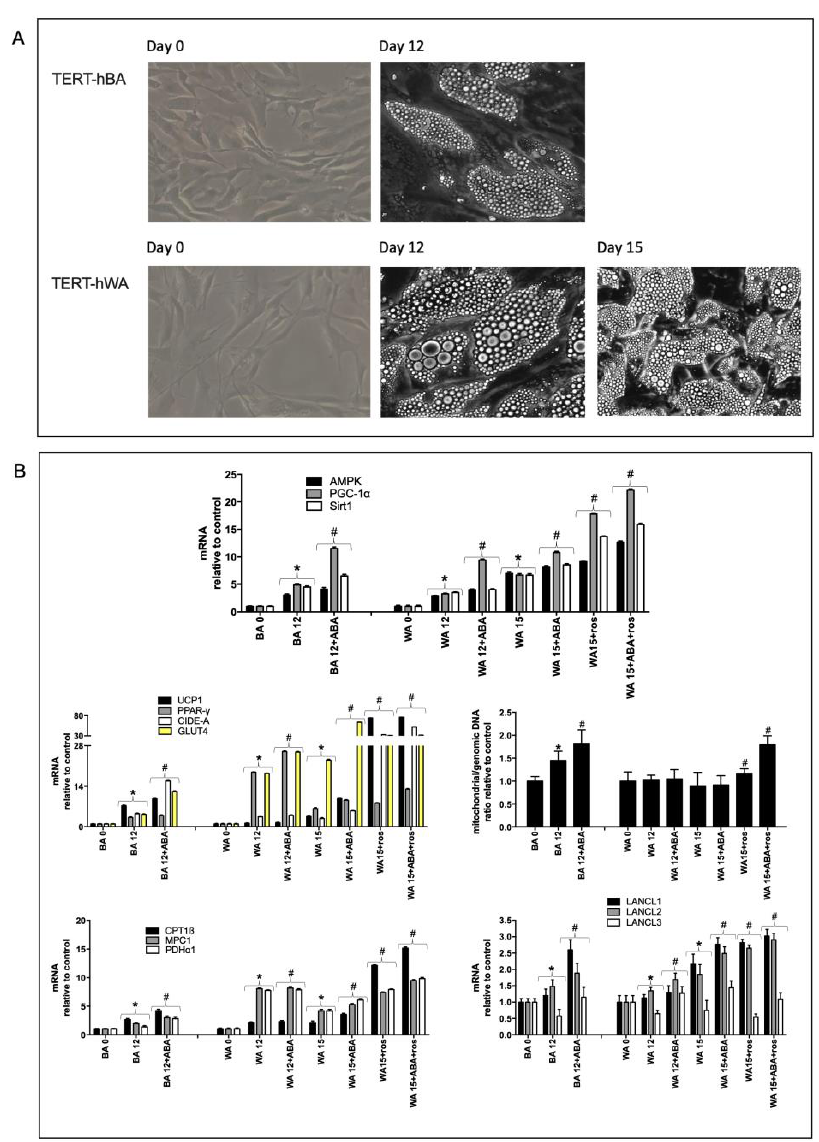
Figure 1. Effect of ABA on human white and brown adipocyte differentiation. ( A ) representative micrographs (magnification × 20 × 40) of immortalized brown (TERT-hBA, upper panels) and white (TERT-hWA, lower panels) human preadipocytes at days 0, 12 and 15 of differentiation. ( B ) qPCR analysis; human TERT-hWA and TERT-hBA preadipocytes differentiated to adipocytes in the absence (control) or presence of 100 nM ABA and/or 1 µ M rosiglitazone: at the indicated time points (day 0, 12 or 15), the mRNA levels of the indicated proteins were evaluated by qPCR. Upper panel, AMPK-1 α , PGC-1 α and Sirt1 mRNAs; central left panel, UCP1, PPAR- γ , CIDE-A and GLUT4 mRNAs;